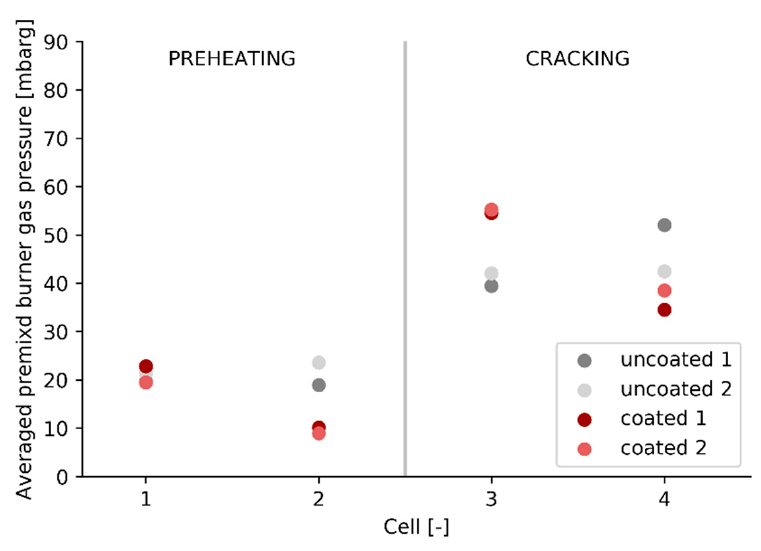
Figure 11. Premixed burner gas pressure measured before every cell for the different experiments. The premixed burner gas pressure is taken at the end of the experiment when the process has reached steady state.